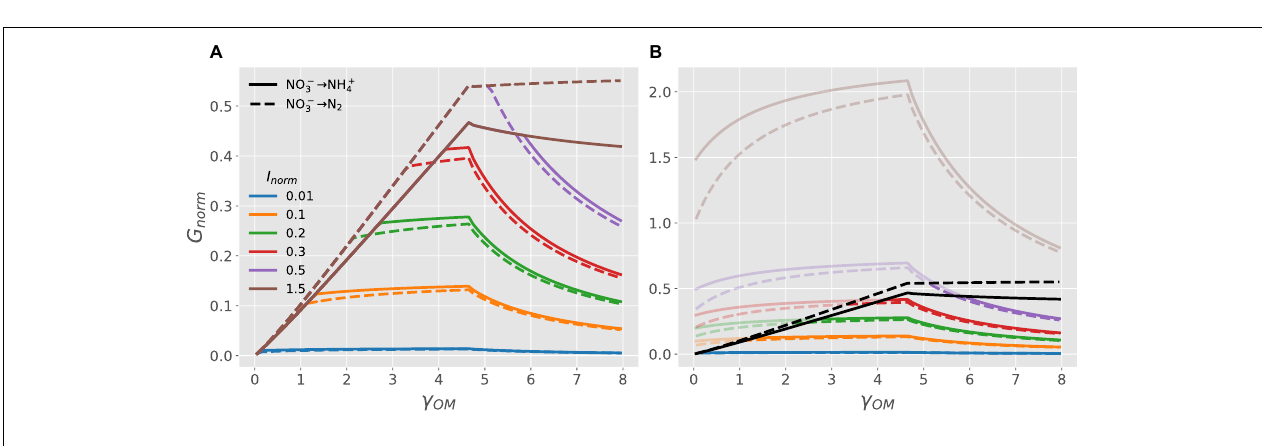
FIGURE 5 | OM without N and nitrate as EA and N-source: (A) normalized microbial growth rate ( G norm ) as a function of N Inorg -availability ( I norm ) and degree of reduction of the OM ( γ OM ; curves with different colors), when the OM is catabolized via denitrification (dashed curves) or DNRA pathway (solid curves). (B) Normalized microbial growth rate under C-limitation [ G C , norm = e , Eq. (3); black curves] and N-limitation [ G N , norm = ( e / y N ) I norm , Eq. (4); colored curves]. The parts of the curves that are not realized [recall that G norm = min (cid:0) G C , norm , G N , norm (cid:1) ] are shaded. Because G C , norm depends only on γ OM , all curves corresponding to different I norm overlap for a given pathway under C limited conditions. An enlarged view of the growth rate curves for I norm = 0 . 01 (blue curves) is provided in Supplementary Figure 1